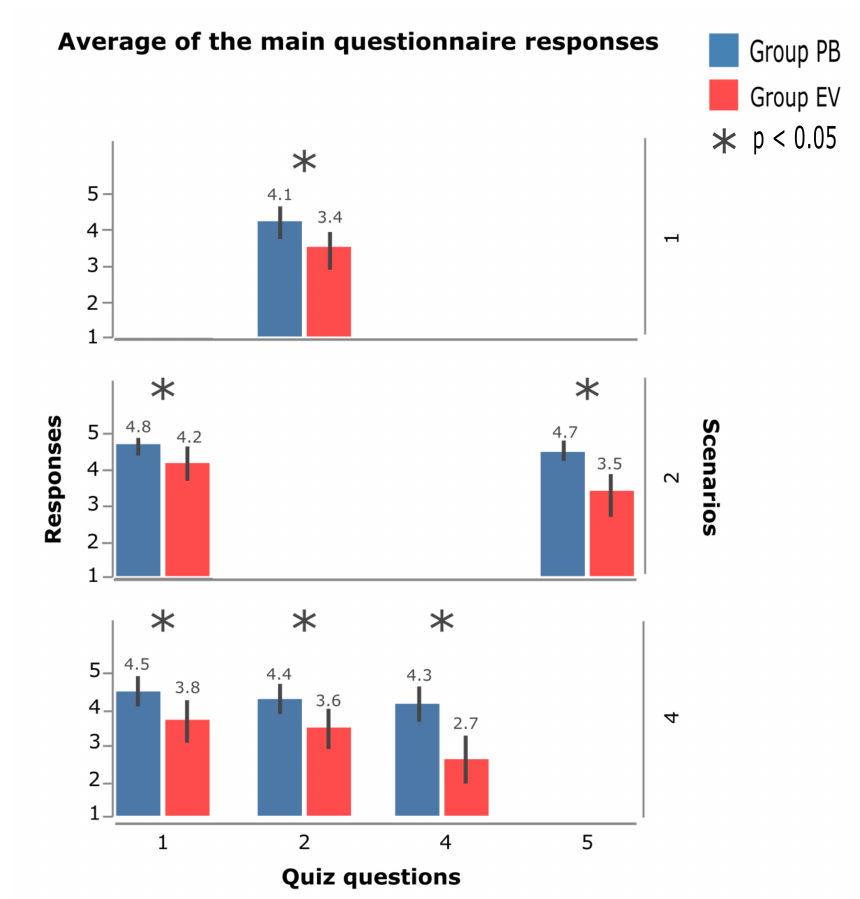
Figure 20. Mean of questionnaire responses between